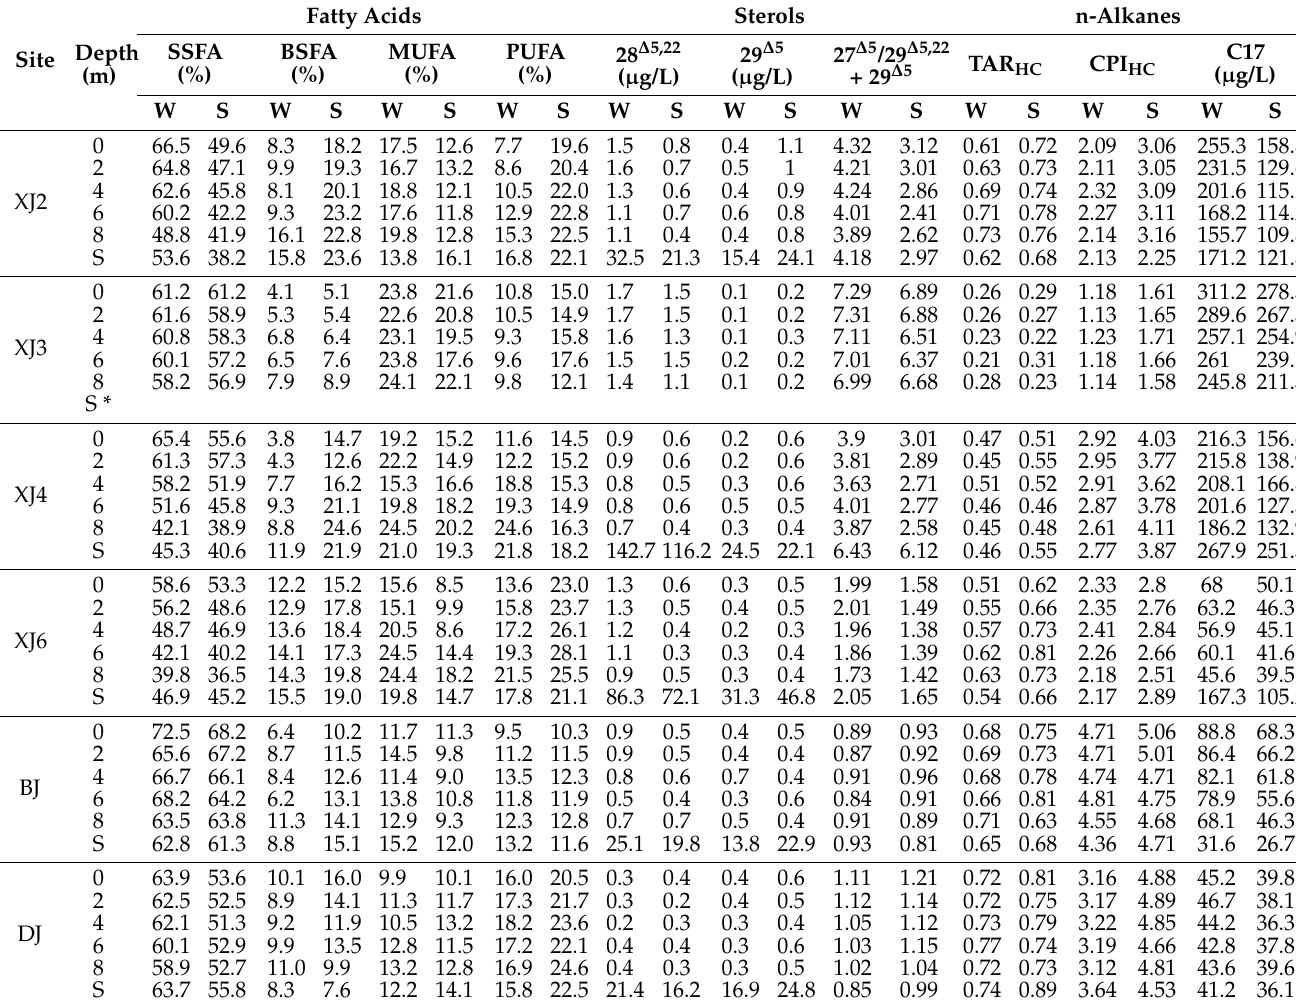
Table 3. Lipid biomarker distribution in water column and surface sediment of Pearl River in seasons of winter (W) and summer (S),